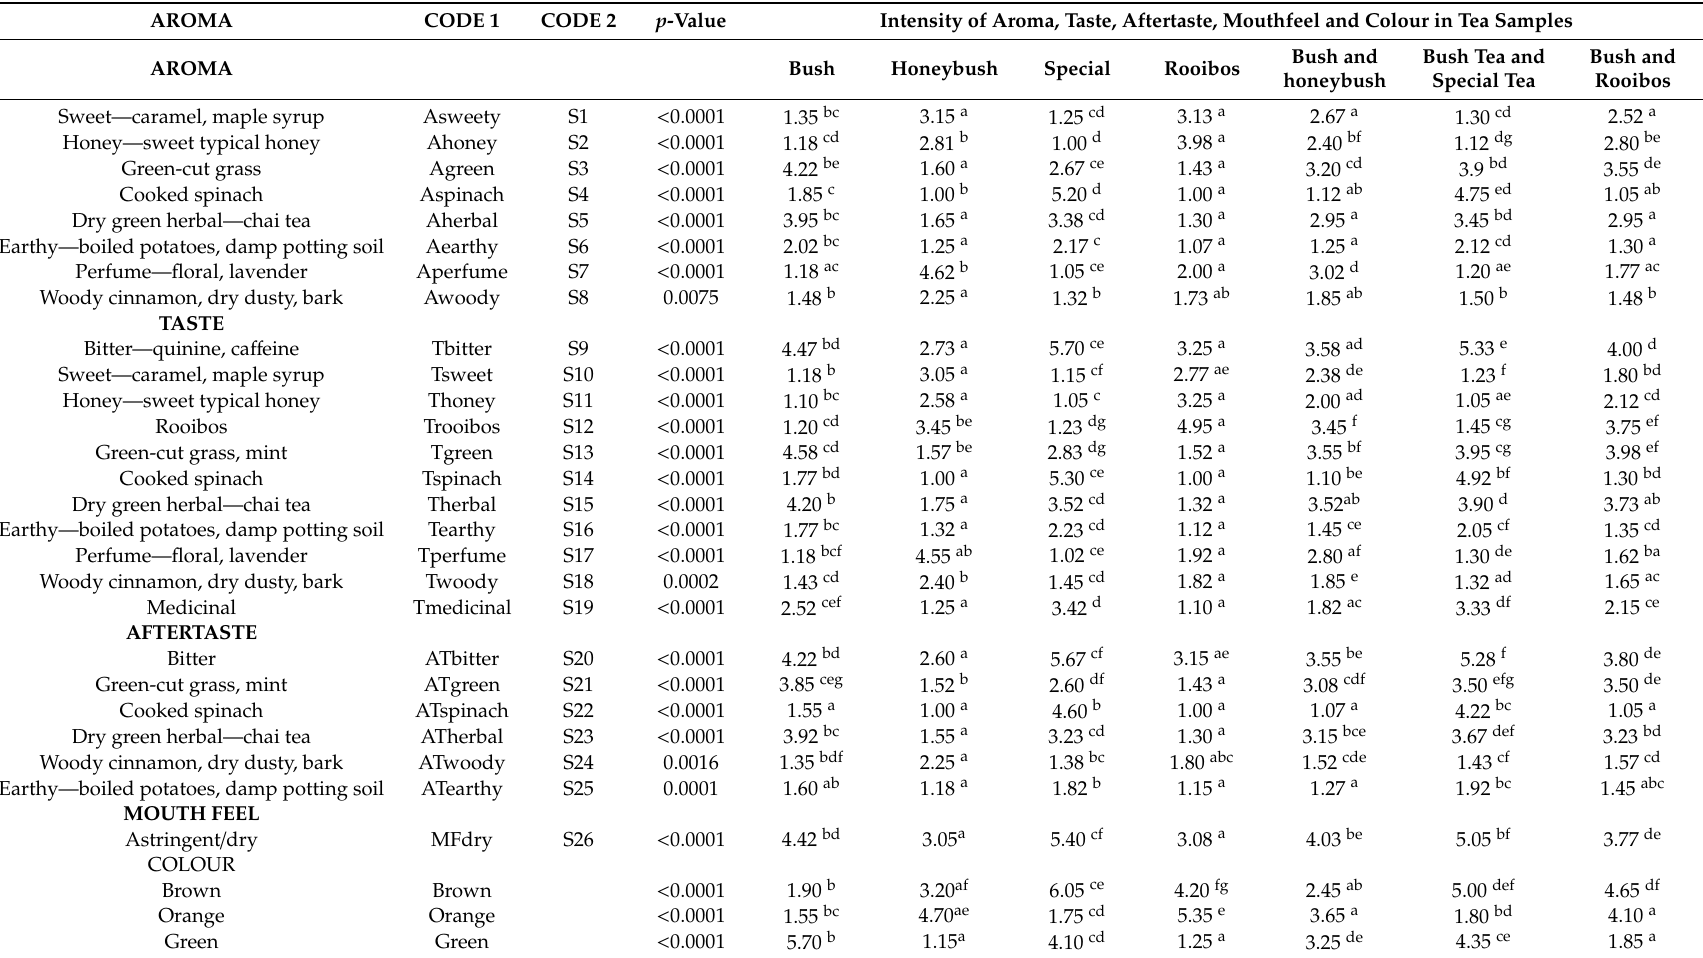
Table 2. Mean values and significant di ff erences in aroma, taste, aftertaste, mouthfeel and colour of the seven selected